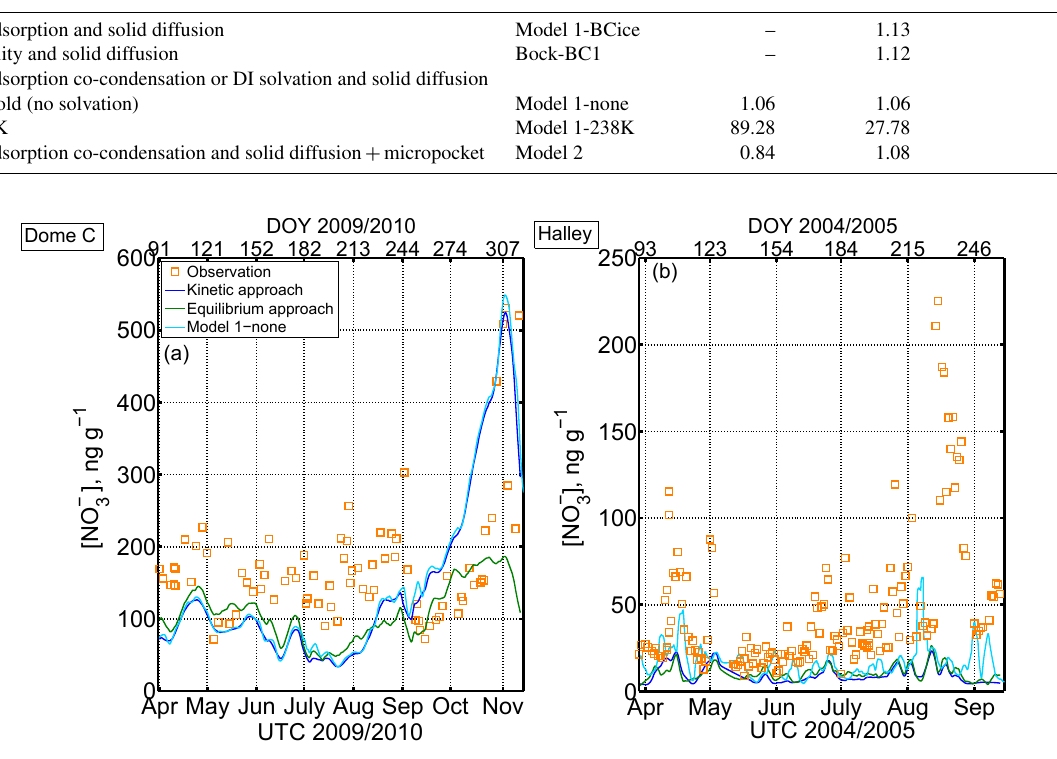
Figure 6. Comparison of the “kinetic” approach (this work, in dark blue) with the “equilibrium” approach (similar to Bock et al., 2016, in green), and the contribution from the co-condensation process (Results from Model 1 – none, in light blue) in winter. The kinetic approach describes the air–snow interaction of nitrate as non-equilibrium kinetic surface adsorption coupled with solid diffusion inside the grain whereas the equilibrium approach describes the interaction as equilibrium solubility coupled with solid diffusion inside the grain. The “Model 1-none” describes the interaction as co-condensation plus non-equilibrium kinetic surface adsorption coupled with solid diffusion within the grain. (a) Results at Dome C. (b) Results at